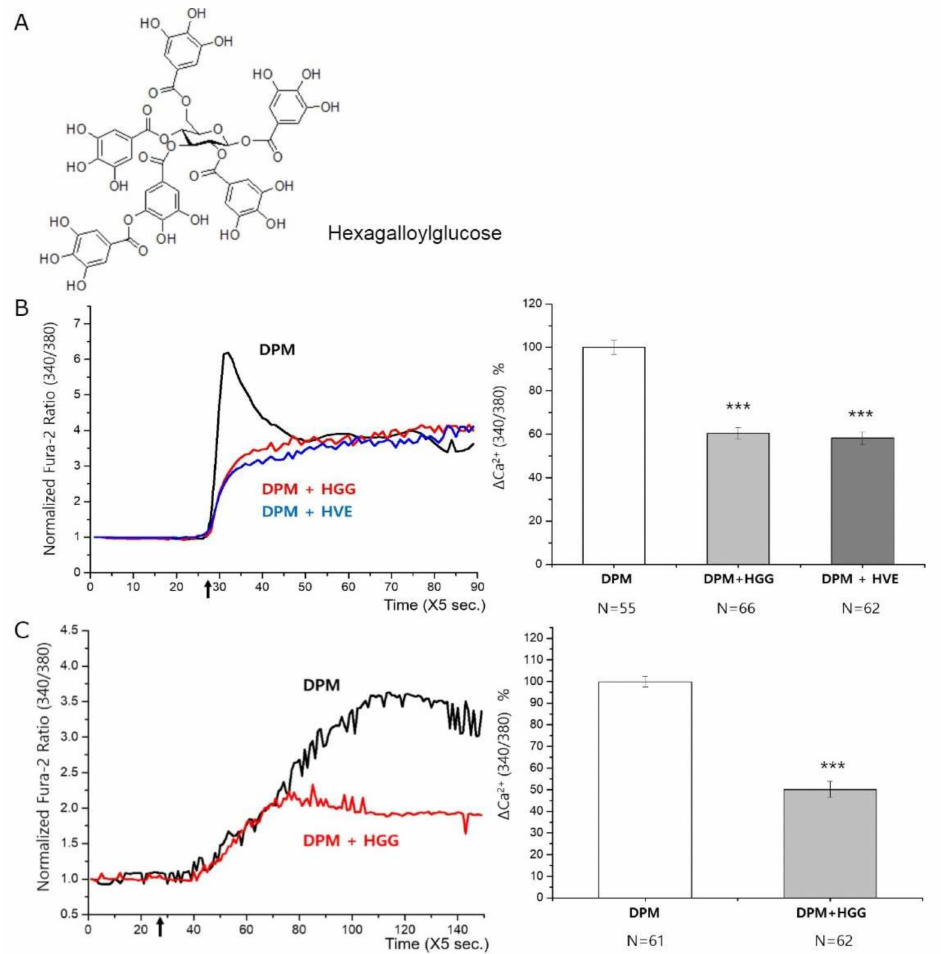
Figure 3. HGG is an active compound that can manifest the protective effect of HVE on the cells. ( A ) The structure of HGG resolved by NMR. ( B ) HGG (100 µ g/mL in the media) showed almost identical effect with HVE (2% in the media) on the [Ca 2+ ] i of HBT-SM cells upon DPM treatment at the indicated time (arrows). ( C ) HGG could also decrease the [Ca 2+ ] i of HaCaT cells, suggesting the protection from the DPM damage. After normalization, the significance of difference to the control (DPM only) was analyzed using a Student’s t -test. *** p <